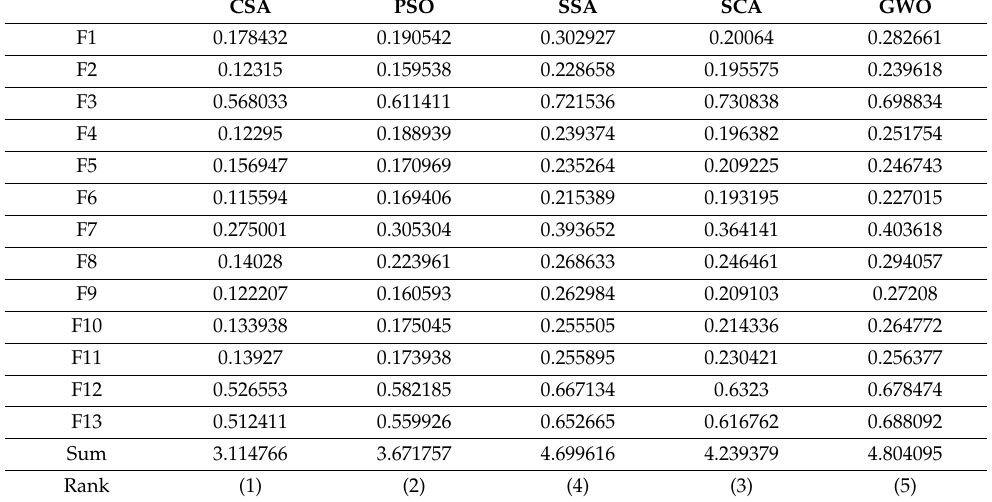
Table 10. CPU time for high-dimensional functions at d = 100.